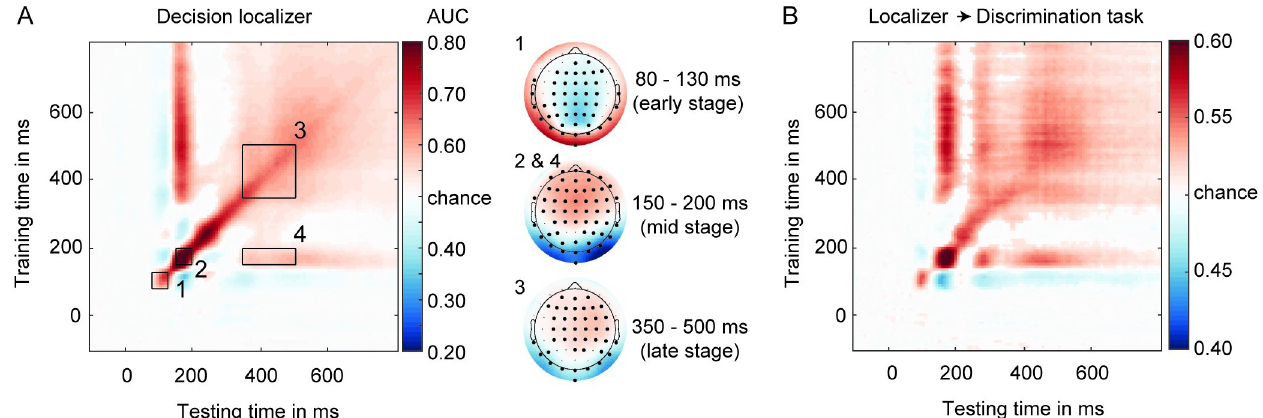
Fig 2. (A) GAT matrix for the decision localizer (all electrodes) and ROI marked by inset black boxes (numbers 1–4). On the right, covariance/class separability maps for each diagonal ROI, indicating the underlying data contributing to the classification performance. Highlighted channels significantly contributed to the classification performance after cluster-based permutation testing over channels (corrected for multiple comparisons). Covariance/class separability maps 2 and 4 are the same because decoding scores within insets 2 and 4 were obtained using the same training time-window. ( B ) Classifiers trained on the decision localizer applied to the main discrimination task (cross-task validation procedure, all electrodes), revealing a high degree of generalizability between the 2 tasks. The underlying data and scripts supporting this figure can be found on FigShare (https://doi.org/10.21942/uva.c.6265233. v1). AUC, area under the curve; GAT, generalization across time; ROI, regions of interest.